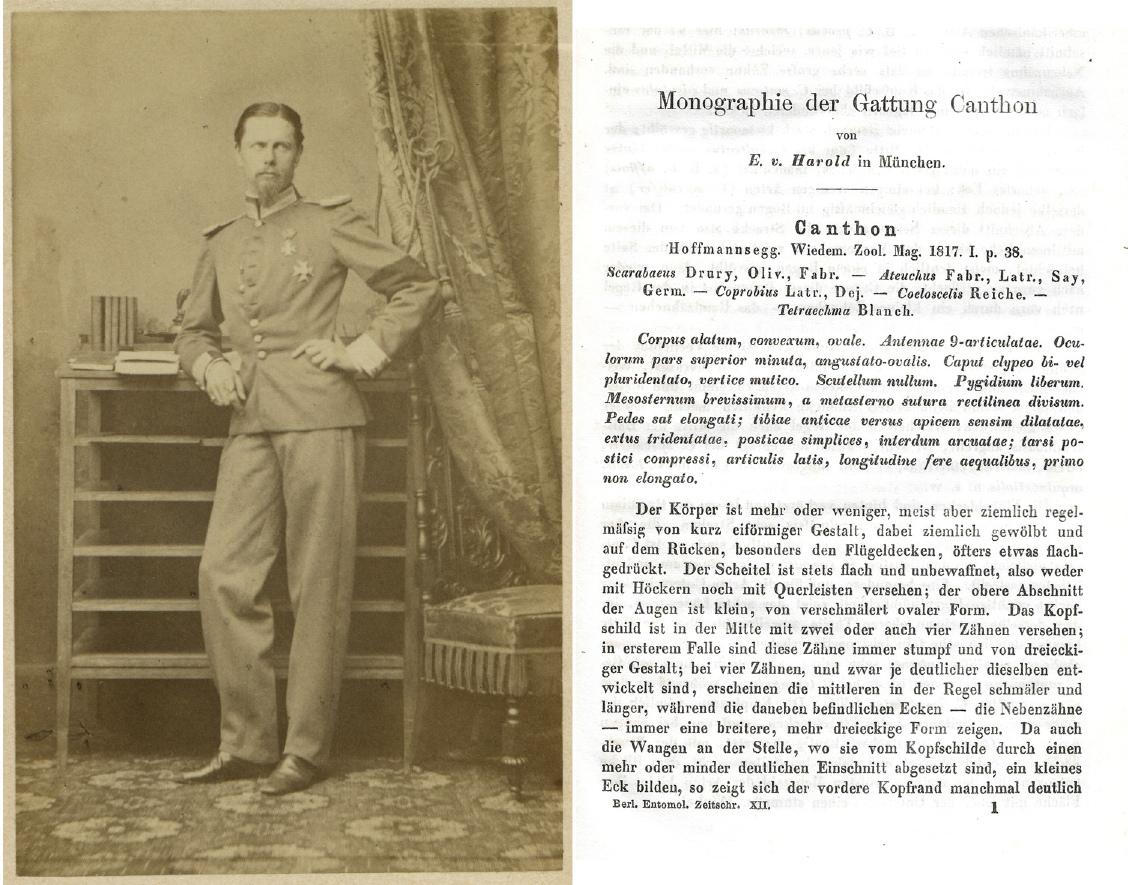
Fig. 2. The German coleopterist Edgar von Harold (1830–1886), one of the first specialists in scarab beetles and author of the only 19 th century revision of Canthon Hoffmannsegg, 1817, in which 97 species were recognized as valid, 46 as new. Harold described two species today positioned in Sylvicanthon Halffter & Martínez, 1977: S. aequinoctialis (Harold, 1868) comb. nov. and S. candezei (Harold, 1869) (portrait courtesy of Editha Schubert, from the archives of the Senckenberg Deutsches Entomologisches Institut; title page of Harold’s revision of Canthon scanned from an original copy housed at the first author’s personal